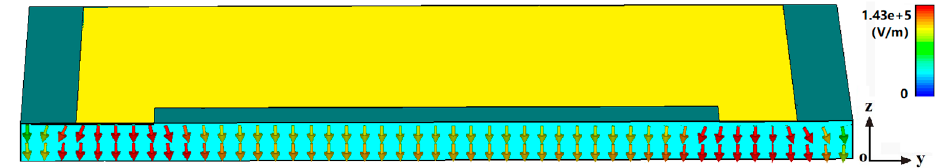
Figure 5. Simulated static electric field strength and direction in the LC layer.